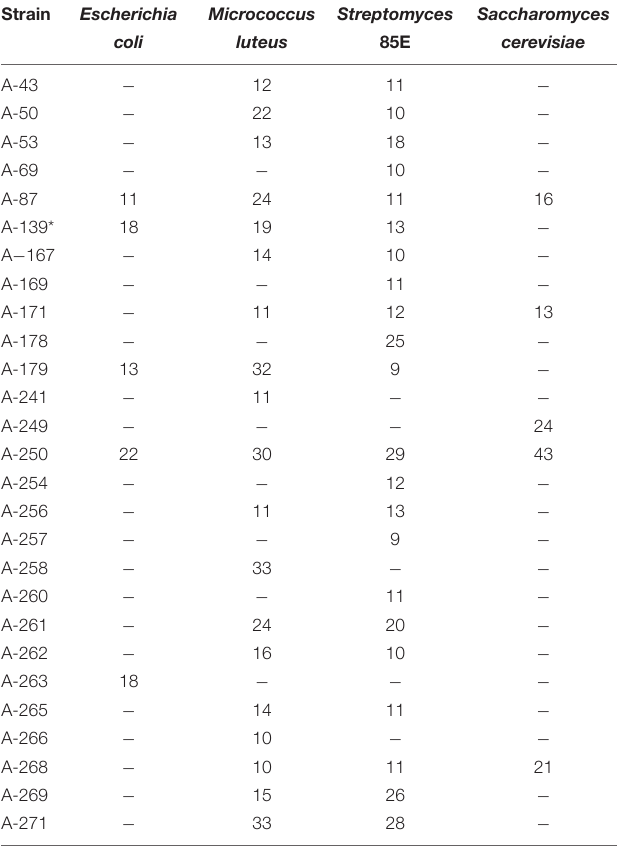
TABLE 1 | Antibiotic activities of atmospheric Actinobacteria cultures against a panel of Gram-negative, Gram-positive bacteria and fungi.